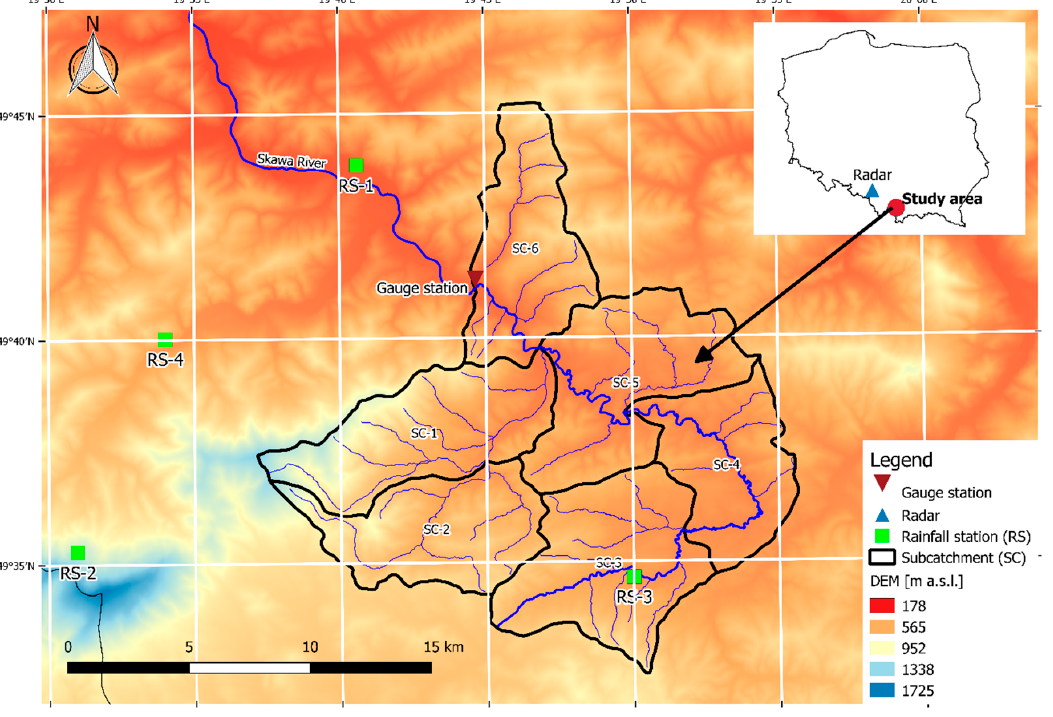
Figure 1. Location of the study area—the Upper Skawa River catchment, in reference to digital elevation model (DEM) and the map of Poland.